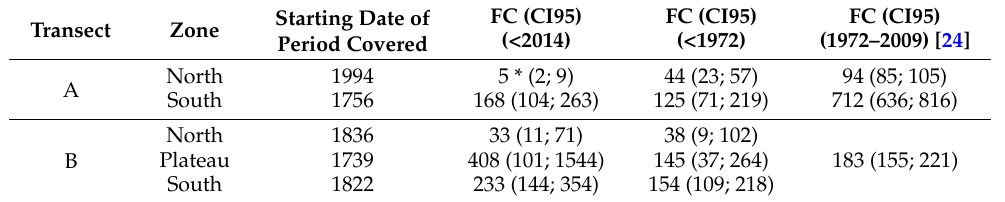
Table 3. Fire cycle (FC) of each transect zone calculated from the cumulative baseline survival function of stratified null models. For each transect zone, we assume that the FC calculated is representative of a period starting with the 10th percentile of the TSF data (i.e., from that date on, 90% of the cells in that particular transect zone were burned). The 95% bootstrap confidence interval (CI95) was obtained after 1000 randomizations with replacement of the original dataset and computation of the FC for each transect using the upper and lower percentiles. FC are calculated for the entire period (prior to 2014) and for the period prior to 1972. FC calculated over the 1972–2009 period by Gauthier et al. [24] in the corresponding regions are also